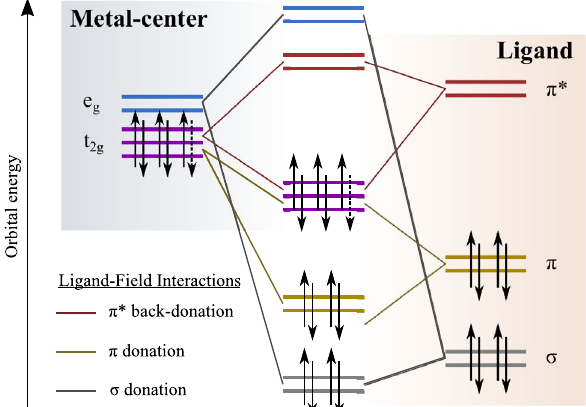
Figure 2. Schematic representation of the metal-ligand interactions in the quasi-octahedral ligand field-splitting convention for Fe II and Fe III complexes with closed shell 3d configurations respectively. The dashed arrow indicates the electron in the t 2g that is only present in the d 6 case. The left and right of the figure shows the molecular orbitals originating from the metal ion and ligand respectively. The combination of these orbitals in an octahedral geometry is depicted in the centre of the